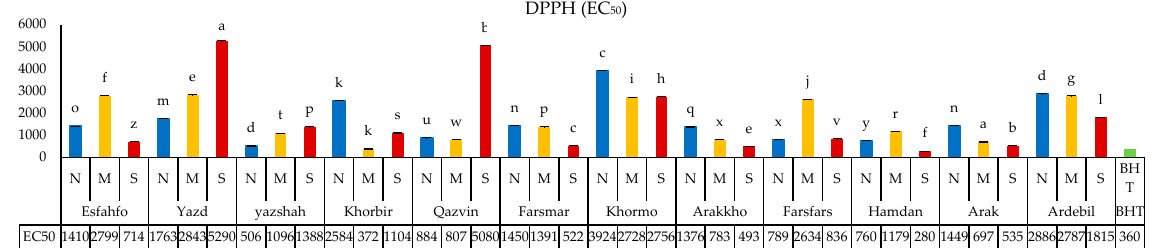
Figure 2. EC 50 of 12 ajowan population extracts based on DPPH assay in comparison to BHT. (N) normal, (M) moderate, and (S) severe drought conditions.